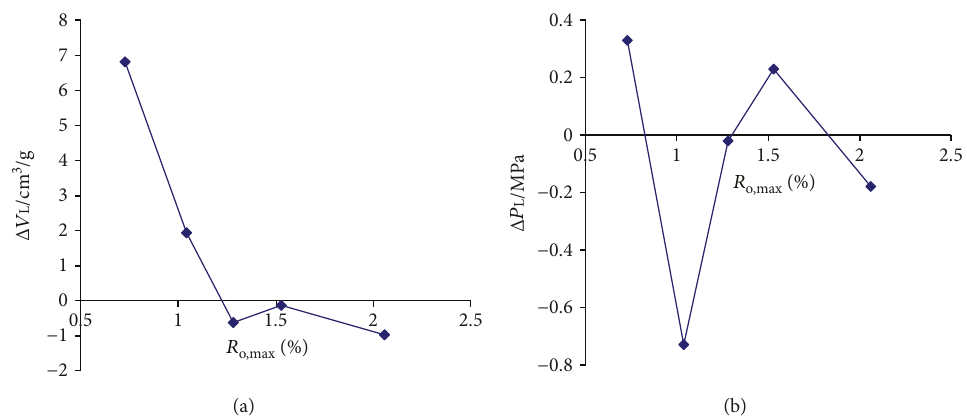
Figure 7: Methane isothermal adsorption constant changes with the coal rank increasing: (a) Δ V (b) Δ P L changes with the coal rank increasing.